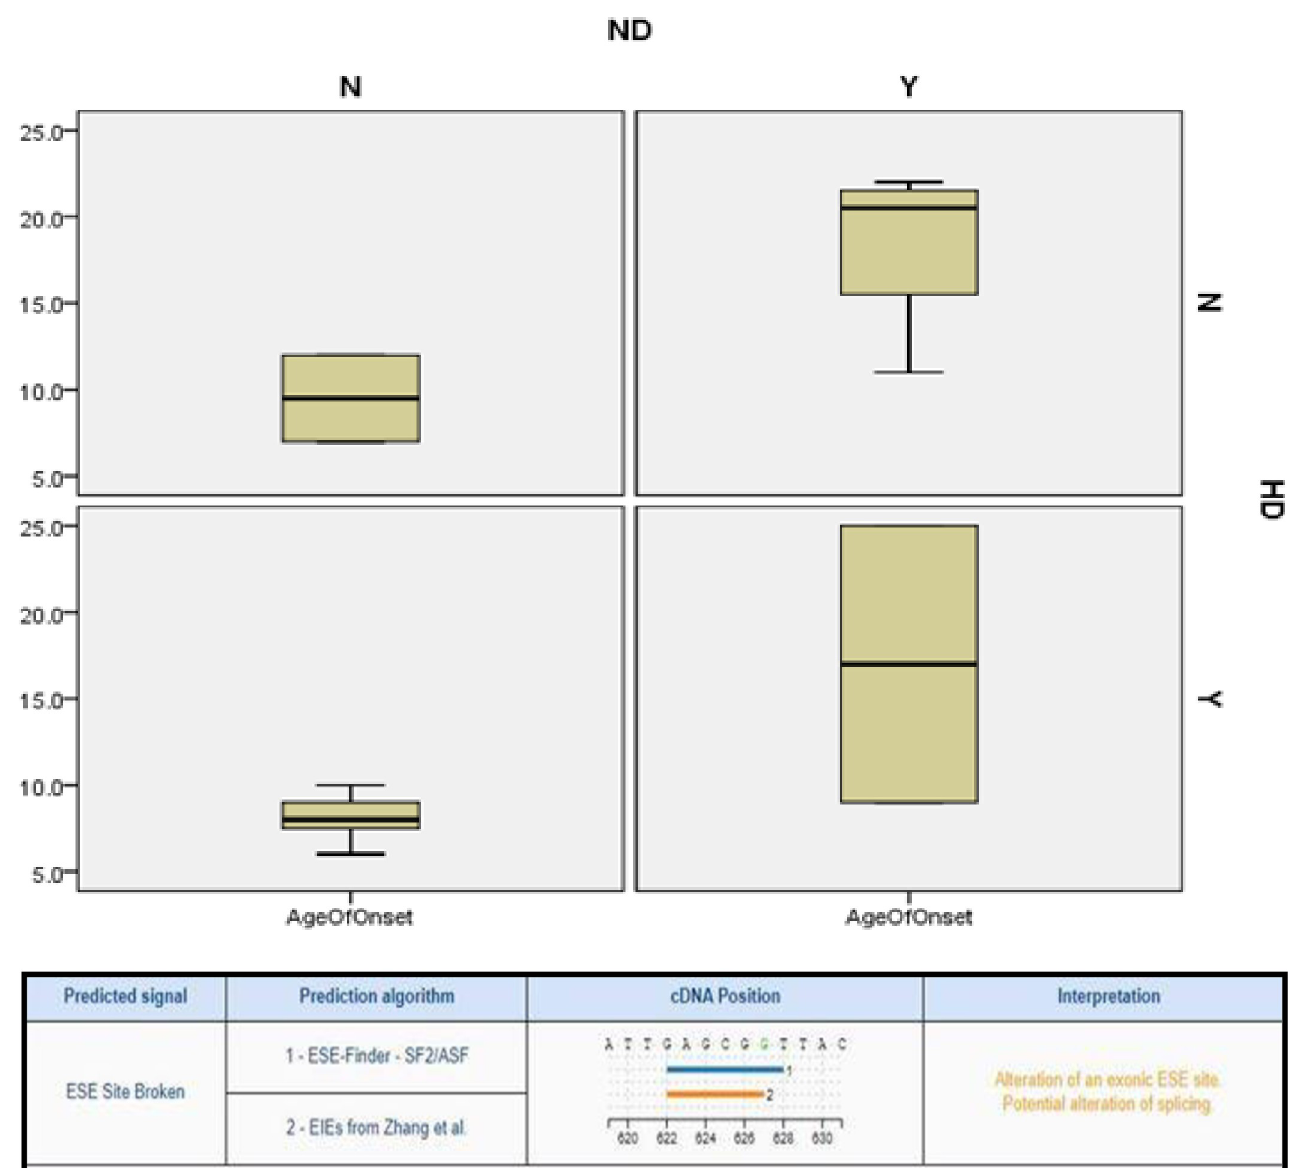
Fig 2. (A) Demonstrating younger age of onset of patients with initial liver disease, compared to patients with neurological manifestations in a Pakistani cohort (B) Pathogenic effect prediction output of HSF program for variation L227Yfs �